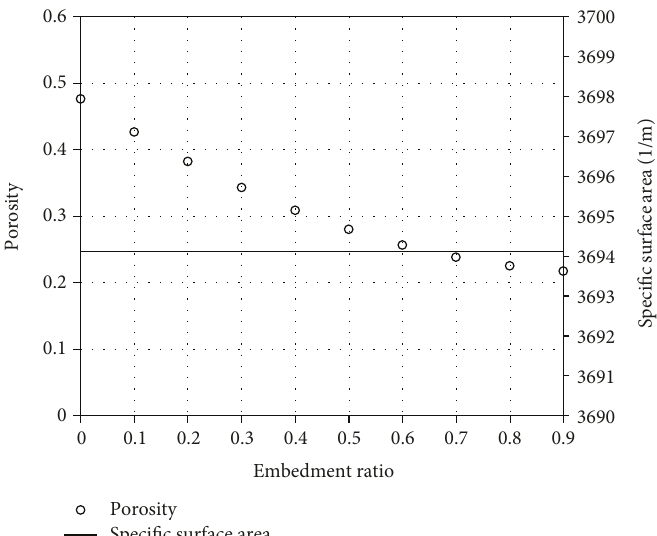
Figure 14: E ff ect of embedment on porosity and speci fi c surface area.